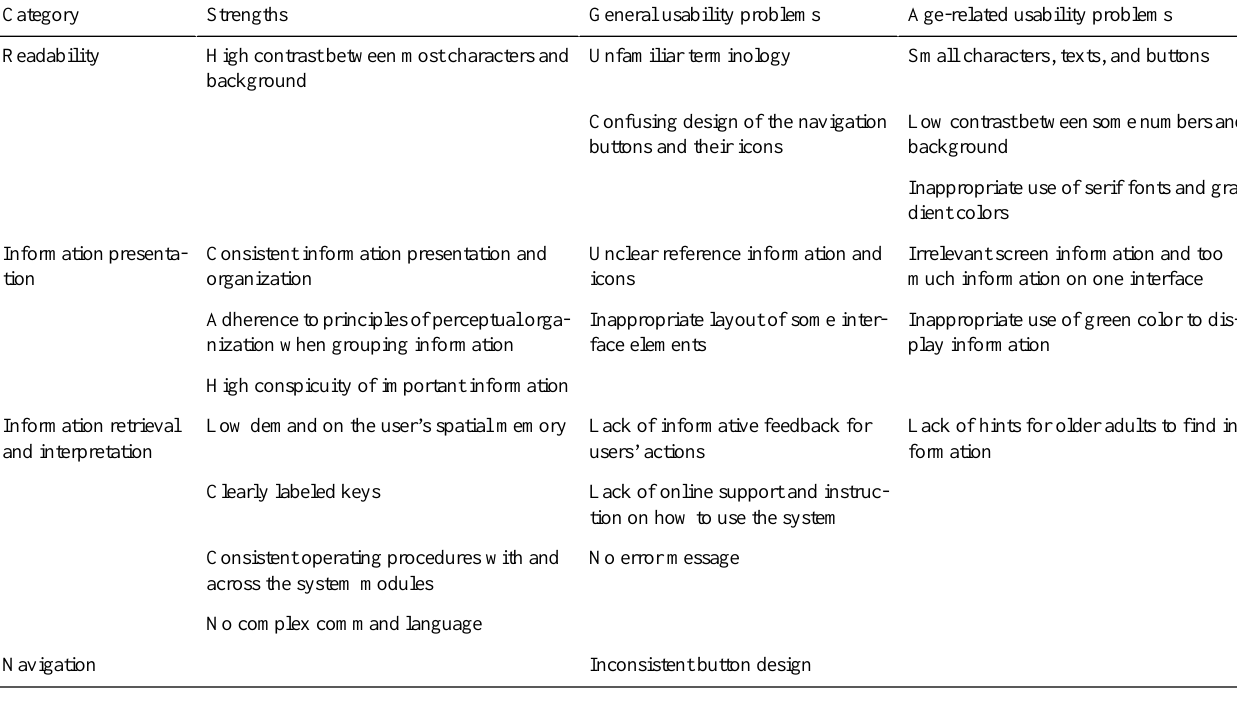
Table 4. Interface design strengths and usability problems identified in the heuristics evaluation.